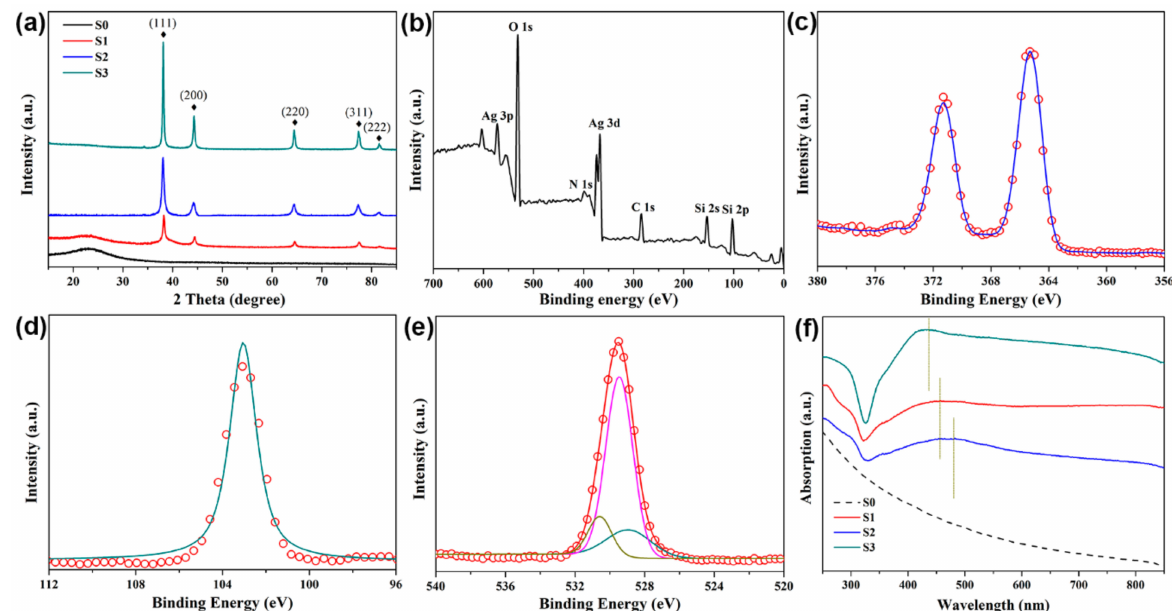
Figure 3. ( a ) XRD of SiO 2 and SiO 2 @Ag composite nanospheres; ( b – e ) XPS analysis of SiO 2 @Ag core-shell NPs (( b ) survey spectrum; ( c ) Ag 3d; ( d ) Si2p; ( e ) O 1s spectra); ( f ) UV-Vis absorption of SiO 2 (S0) and SiO 2 @Ag with different